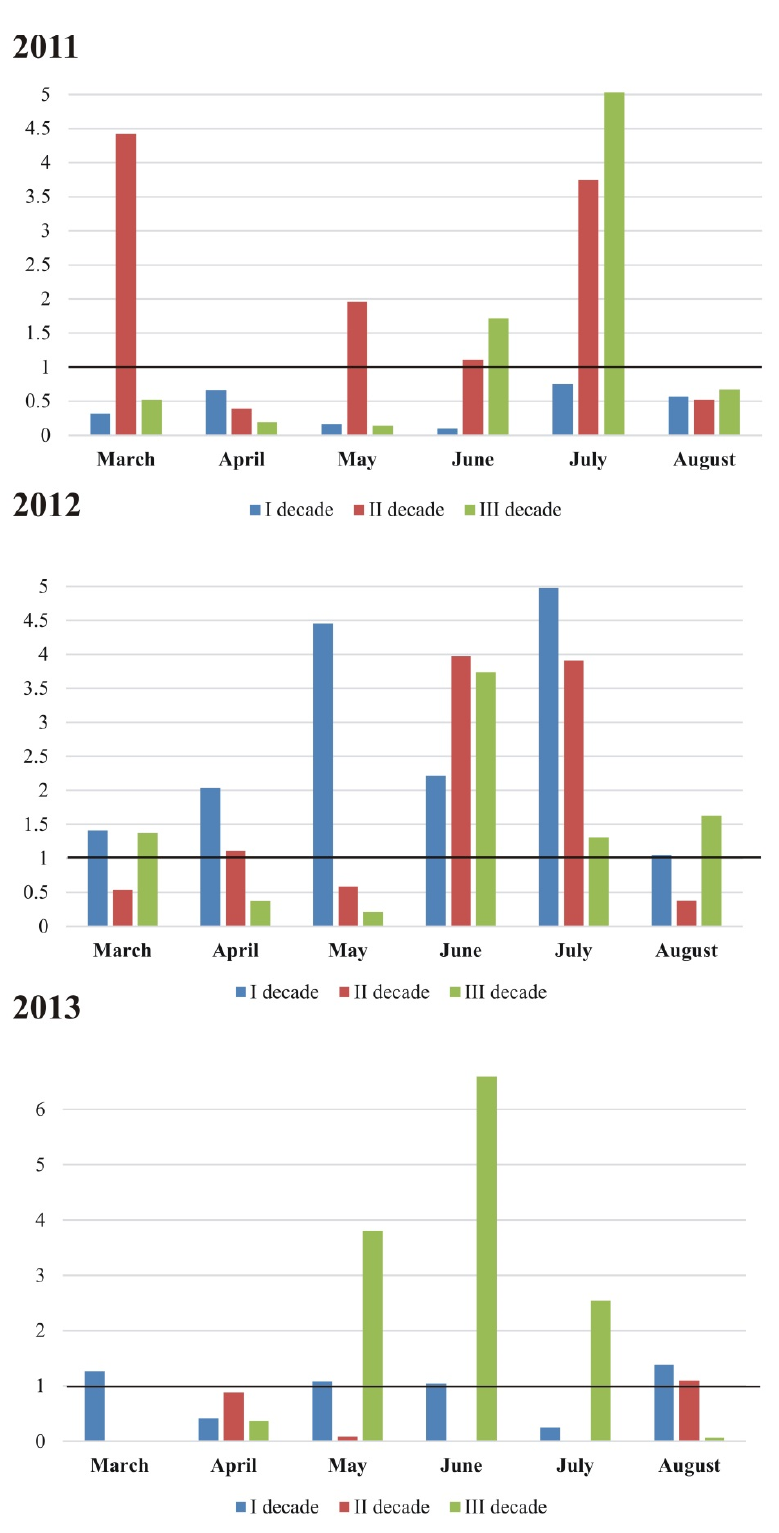
Figure 1. Sielianinov index values reflect the diversity in weather conditions in the years of the study (Interpretation: K > 1.5 indicates excessive moisture for all plants, K = 1.0–1.5 indicates sufficient moisture, K = 0.5–1.0 indicates insufficient moisture, and K < 0.5 indicates moisture less than the requirement for most plants (drought)). The black line indicates a lower limit of sufficient moisture. I, II and III – decades of the month.